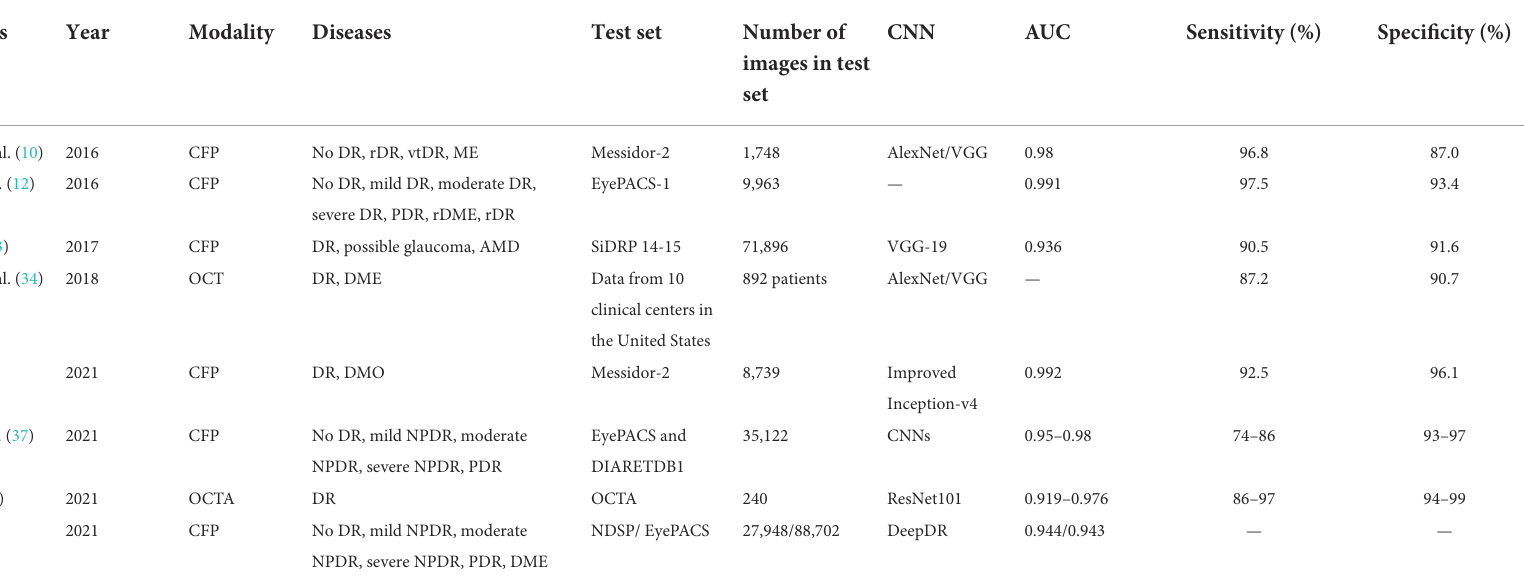
TABLE 1 Typical deep learning systems for NPDR and